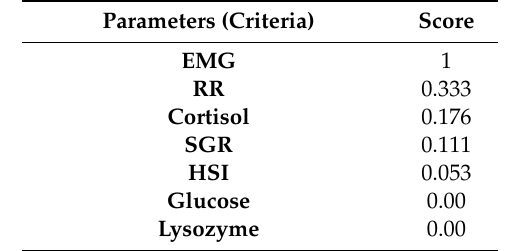
Table 8. Diagnostic frame of the scores obtained for the criteria (parameters) by means of the NSFDSS in the case of Hypothesis 1. Parameters